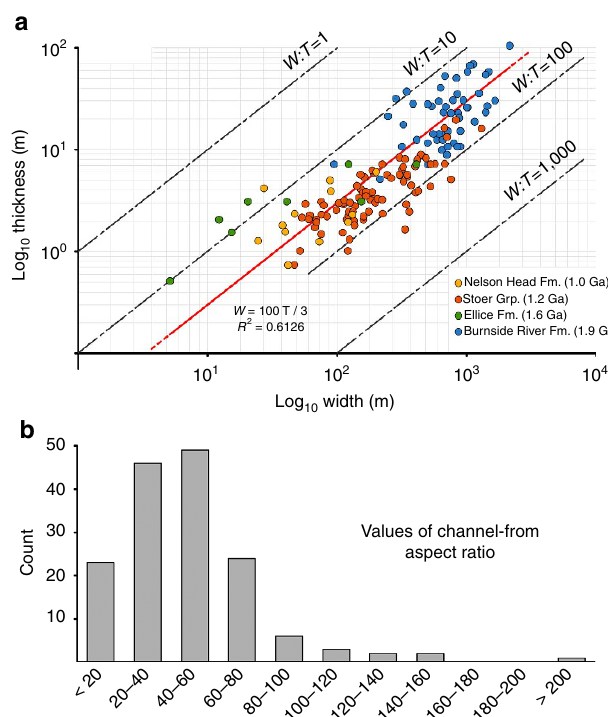
Figure 2 | Morphometry of exposed Proterozoic channel forms. ( a ) Logarithmic width–thickness plot reporting the database of 156 Proterozoic channel forms (Supplementary Data 1). Linear regression line is reported in red. ( b ) Histogram showing relative frequencies of values of aspect ratio in the database shown in a